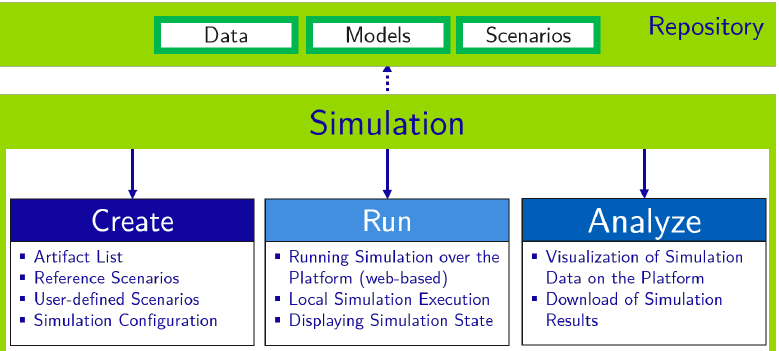
Figure 7. Basic functionalities of Simulation and their